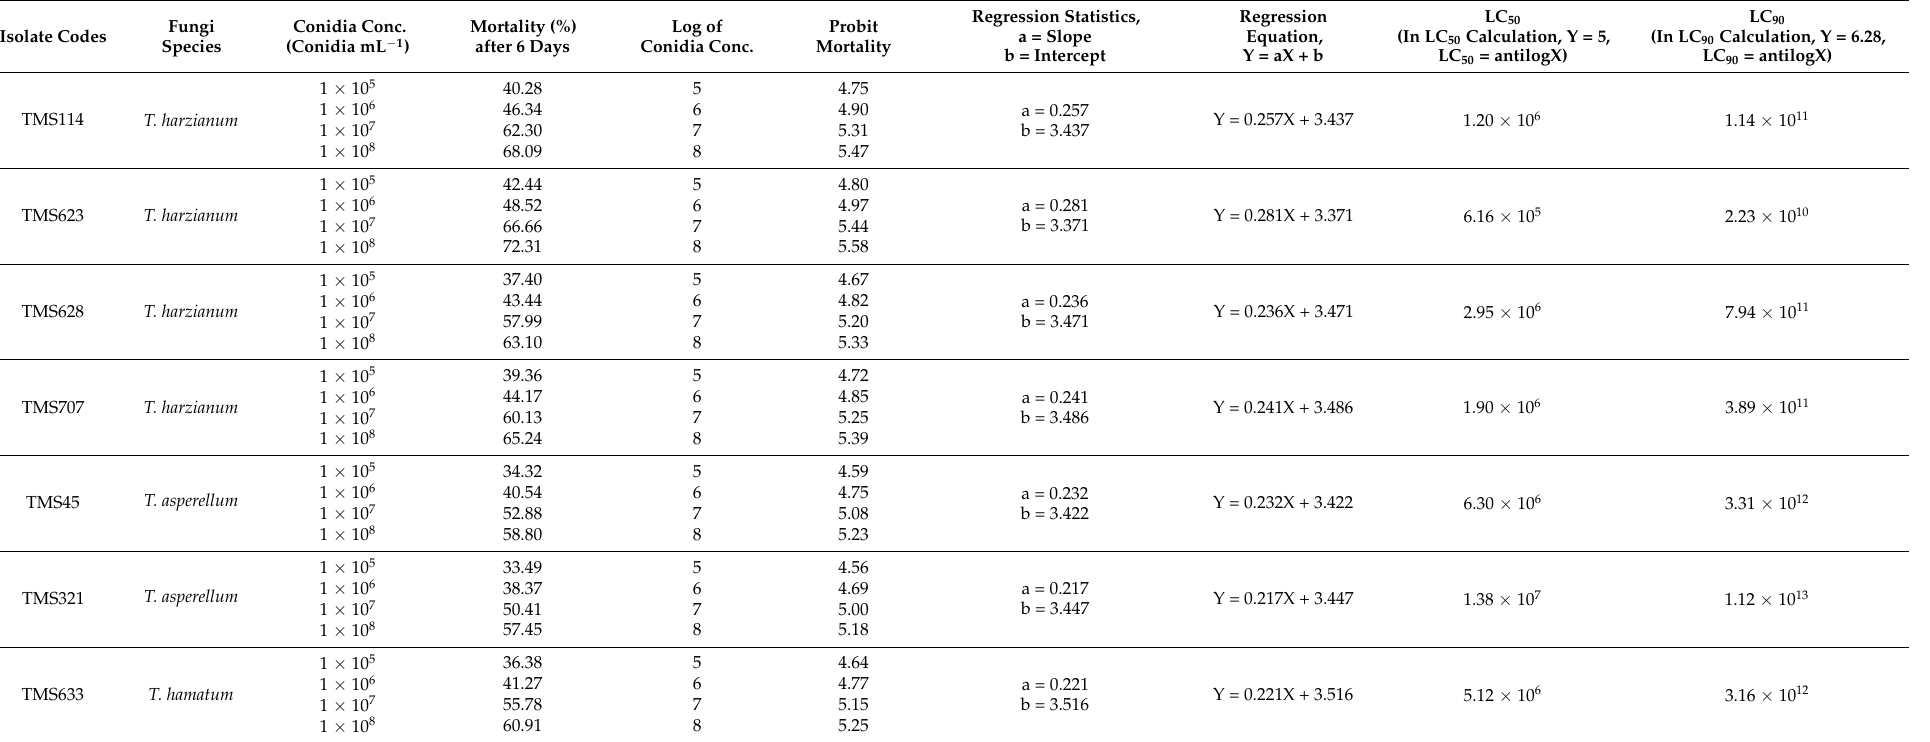
Table 3. LC 50 & LC 90 values for the efficacy of isolates against adults using different concentrations (1 × 10 5 to 1 × 10 8 conidia mL − 1 ) of conidia suspension after six days